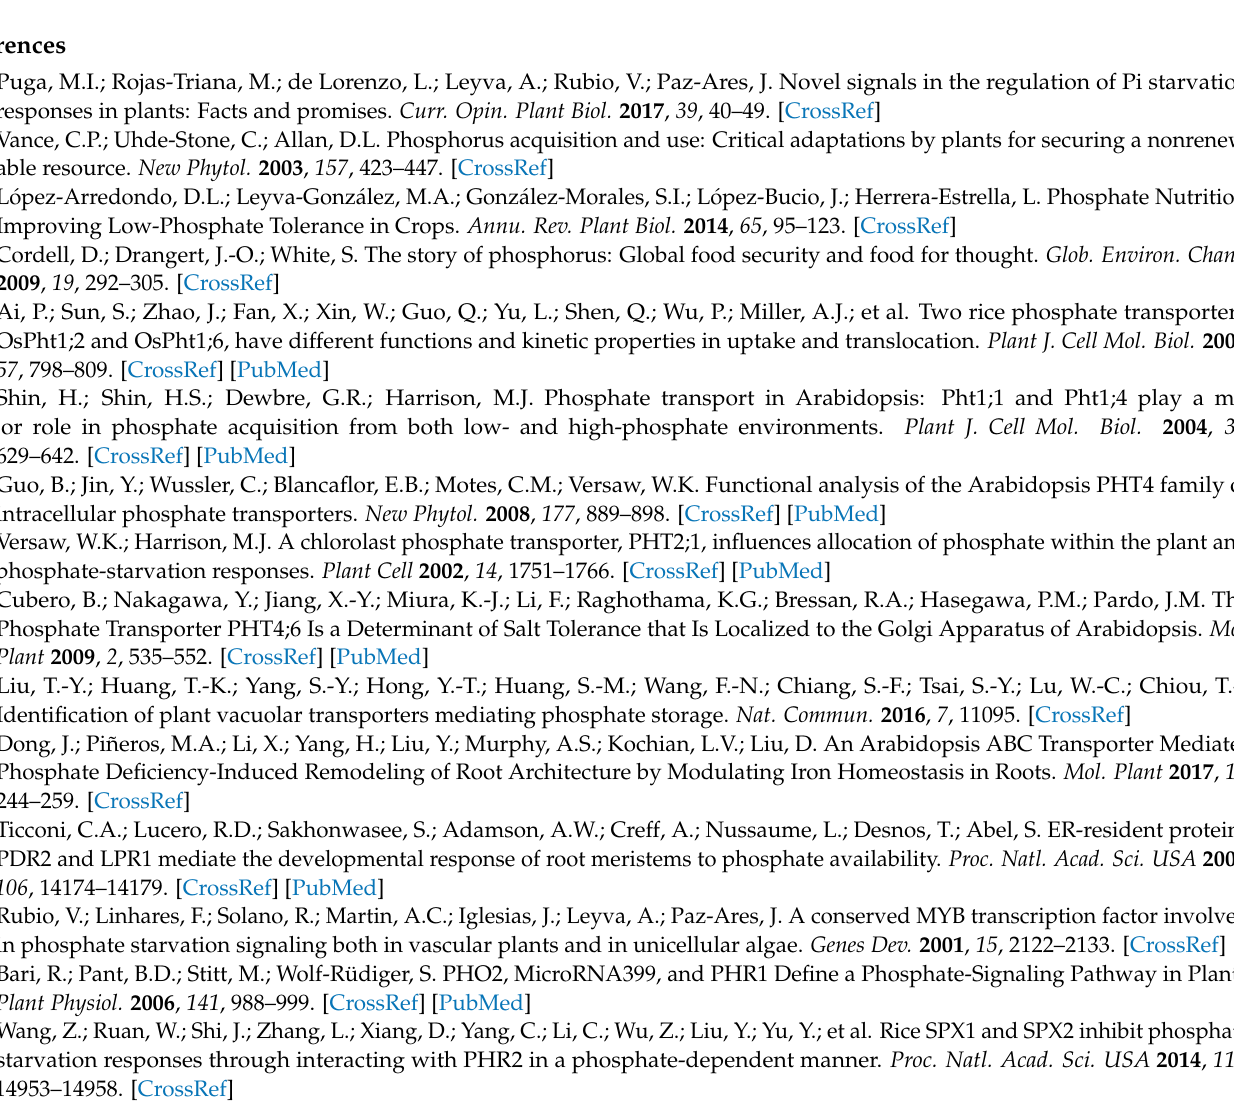
Overview of RNA-seq sequencing data, Table S3: Identification of differentially expressed genes at the transcript and protein level, Table S4: Gene ontology (GO) enrichment analysis of DET and DEP, Table S5: Identificaito of differentially expressed transcription